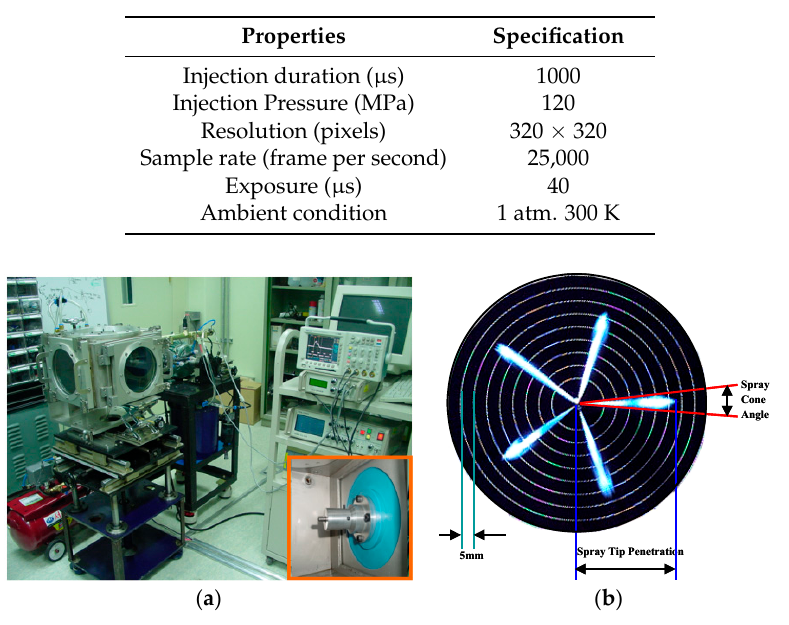
Figure 5. Spray visualization measurement; ( a ) Visualization apparatus, ( b ) Definition of spray parameter.